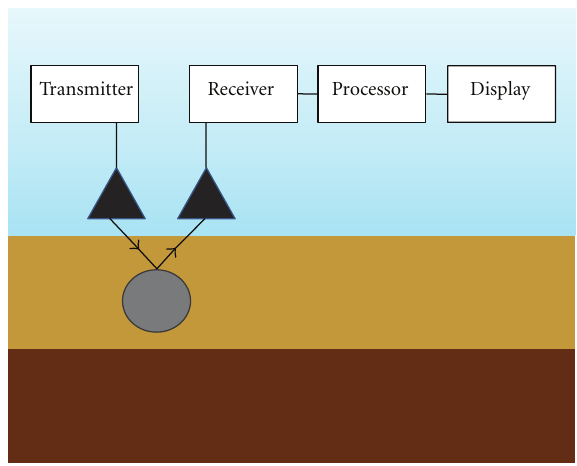
Figure 1: Block diagram of a GPR